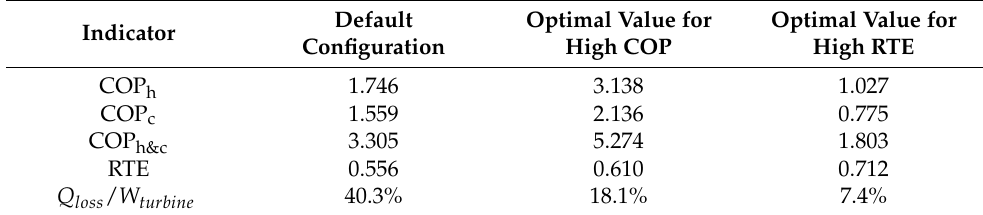
Table 4. Key performance indicators for optimal